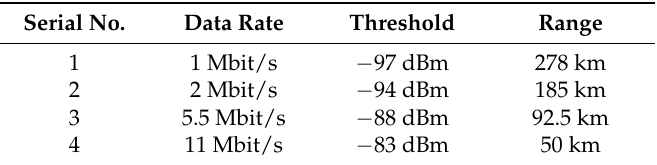
Table 2. Multi-rate setting for NC-NET ( f GHz = 1